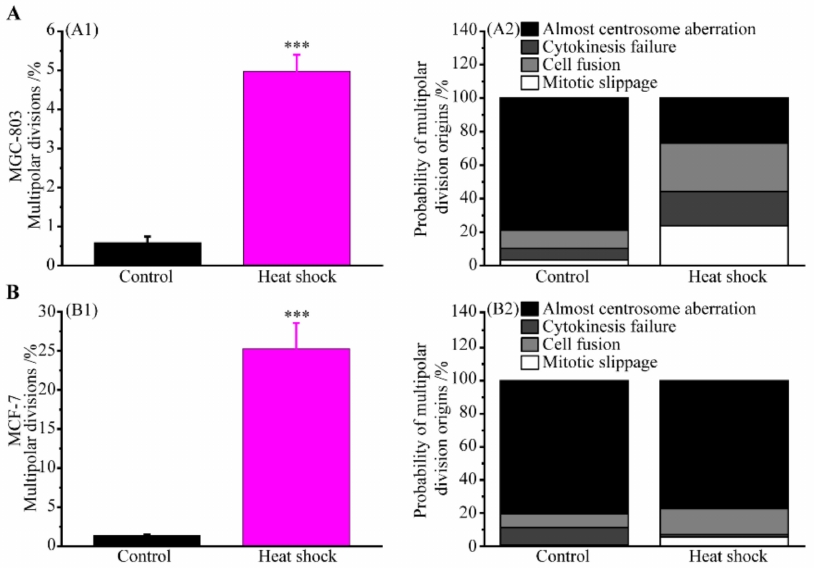
Figure 7. Multipolar divisions caused by heat stress and their probabilities originated from mitotic slippage, cytokinesis failure, cell fusion, and centrosome aberrations. ( A ) Multipolar divisions of MGC-803 cells; ( A1 ) the multipolar divisions frequency of MGC-803 cells (mean values ± SD are shown from three independent experiments); ( A2 ) the multipolar divisions probability originated from mitotic slippage, cytokinesis failure, cell fusion, and centrosome aberrations, respectively. ( B ) Multipolar divisions of MCF-7 cells; ( B1 ) the multipolar divisions frequency of MCF-7 cells (mean values ± SD are shown from three independent experiments); ( B2 ) the multipolar divisions probability originated from mitotic slippage, cytokinesis failure, cell fusion, and centrosome aberrations, respectively. p -value < 0.05 was considered statistically significant, *** p <